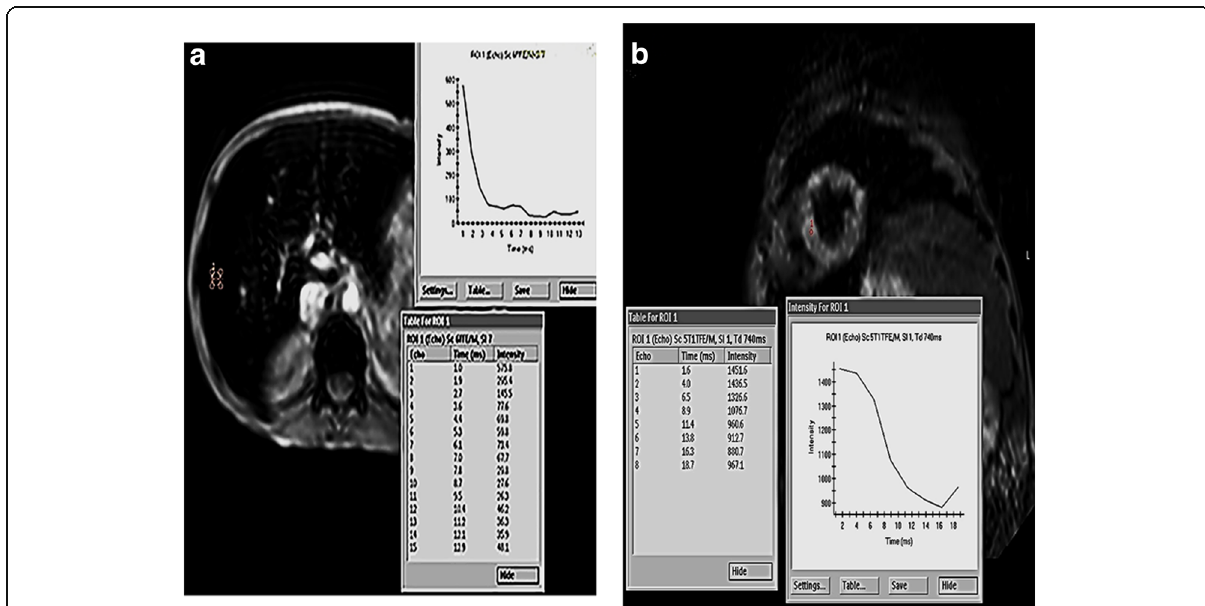
Fig. 1 Time-signal intensity curves delivered from ROI positioned in the right liver lobe ( a ) and interventricular septum ( b ) at 15 different TE (1.1- 12.9ms) for the liver and 8 different TE (1.6-18.7ms) for the